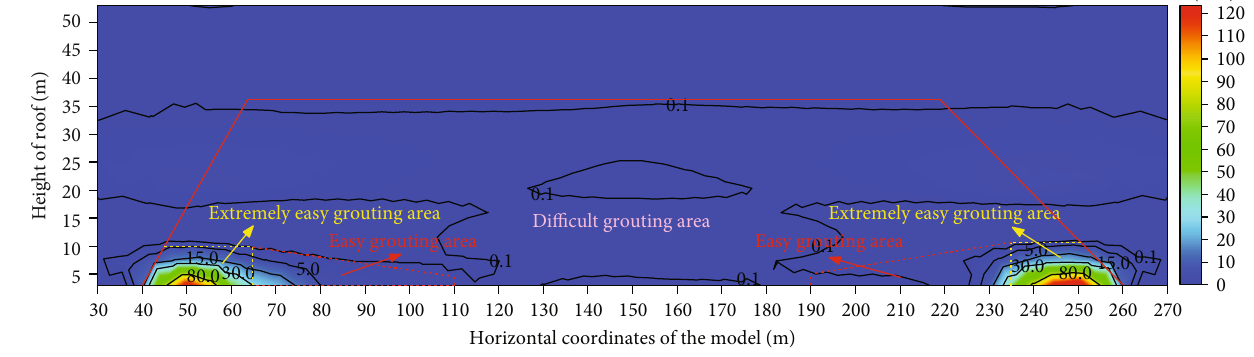
Figure 15: Regional division of grouting di ffi culty in overburden. Table 3: Classi fi cation of grouting di ffi culty in overburden due to the mining in fl